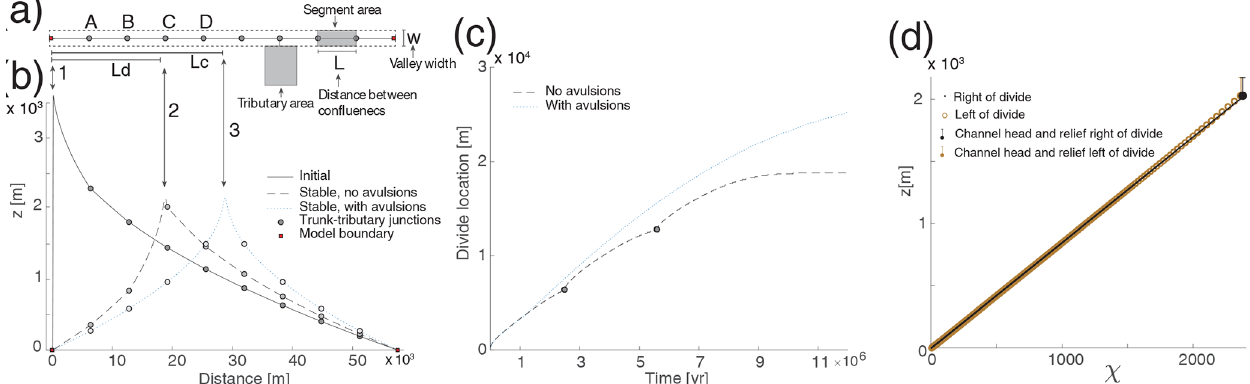
Figure 5. Simulations of along-valley wind-gap migration across confluences with tributaries. (a) Plan view schematic of a one-dimensional model domain that simulates a valley of constant width ( w ) that is drained by a trunk channel (dark line) with equally spaced ( L ) confluences with tributaries. The drainage area of nodes between confluences is fixed ( (cid:49)x × w ; see Table 1 for values of model parameters). The drainage area of a tributary is the local area that is added at each confluence (an example is represented here by a gray rectangle). L d and L c mark the distance from the left edge of the model domain to the location of a stable wind-gap position and to the center of the model domain, respectively. Confluences marked A–D are referred to in Fig. 7a. (b) An example of simulated topographic profiles along the trunk channel: (1) a topographic profile of the simulation’s initial condition; (2) simulated steady-state topography that develops from the initial condition in profile no. 1 through a fixed confluence simulation. Note that the wind gap attains a stable position away from the center of the model domain (i.e., L d < L c ). Also note that this steady position occurs adjacent to a trunk–tributary confluence on the shrinking side of the wind gap; (3) simulated steady-state topography with avulsions (light gray circles mark the mean location of trunk–tributary confluences, which is the same as that of the fixed confluence). The wind gap’s stable position is at L c . (c) Simulated wind-gap location vs. time for the simulations in panel (b) . Note that the plot shows the model duration until the wind gap in the fixed confluence simulation attained a stable position (case 2 in panel b ). (d) A χ – z plot (Perron and Royden, 2013) for case 2 in panel (b) . Note that the relief from each channel head to the wind gap is also marked (see legend). The channel head is defined based on where the topographic profile shifts from concave to convex. The channel head to the right of the divide (a black filled circle in the χ – z plot) is at the adjacent tributary confluence. Model parameters are given